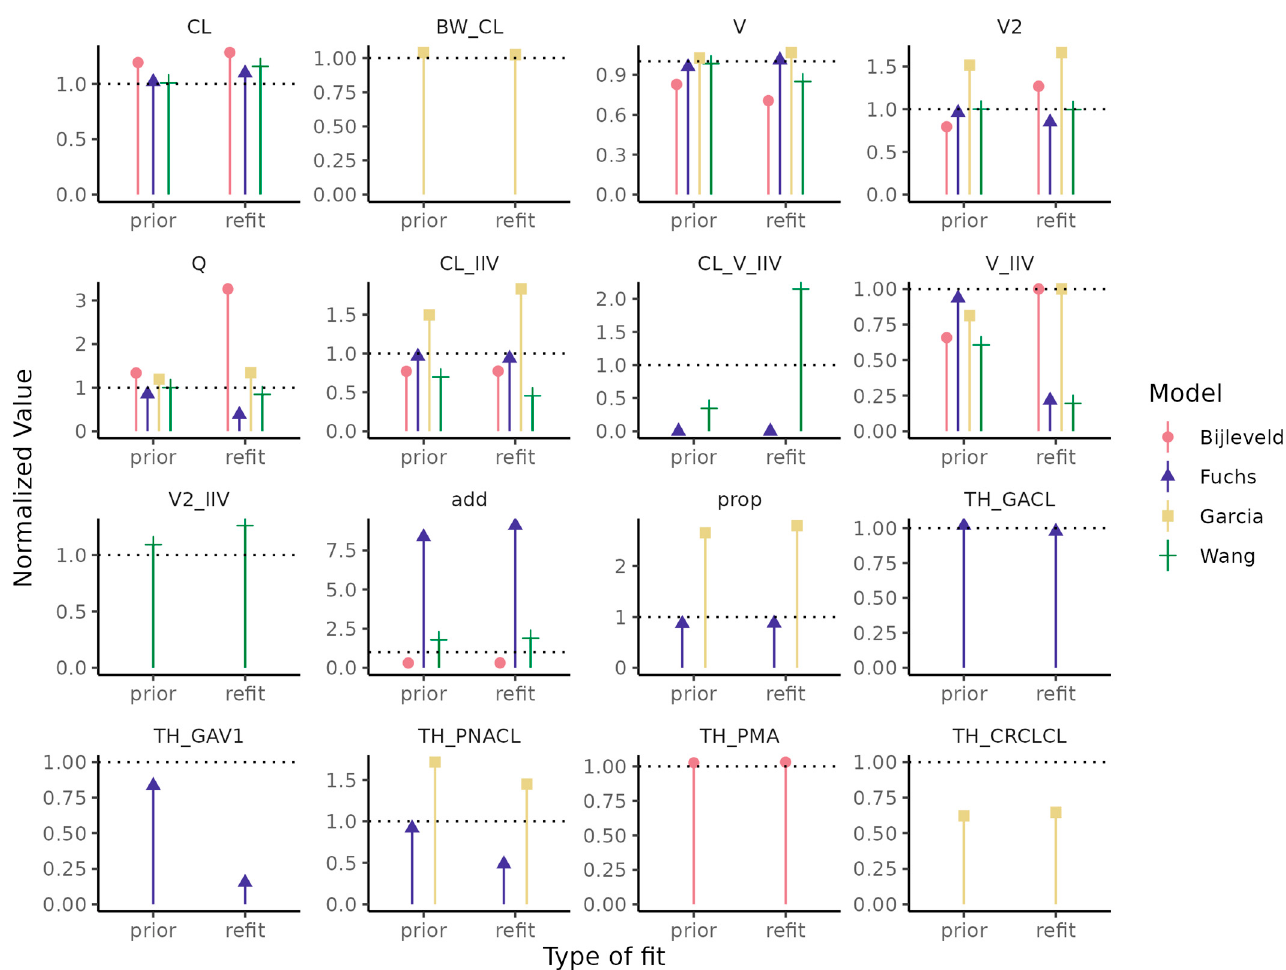
Figure 6. Parameter estimates, normalized to the published value, for the refit with informative prior (“prior”) and refit without prior (“refit”) versions of each of the Wang, Bijleveld, Fuchs, and Garcia popPK models. CL: Clearance; BW_CL: effect of body weight on CL; V: volume of distribution of central compartment; V2: volume of distribution of peripheral compartment; Q: intercompartmental clearance; IIV: interindividual variability; add: additive error; prop: proportional error; TH_PMA: effect of PMA on CL; TH_GACL: effect of GA on CL; TH_GAV1: effect of GA on V1; TH_PNACL: effect of PNA on CL, TH_CRCLCL: effect of creatinine clearance (CRCL) on CL.